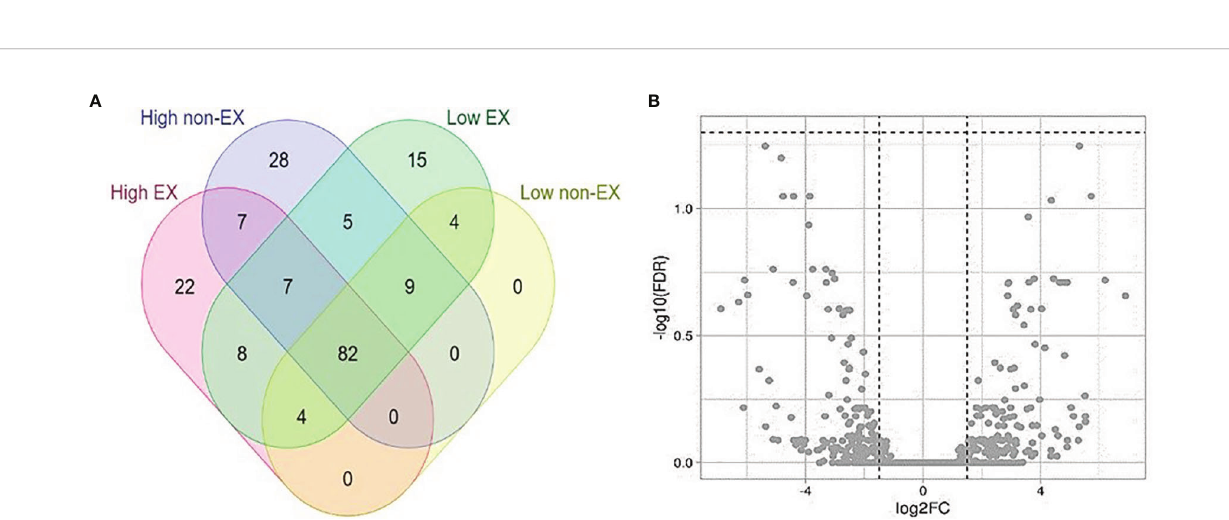
FIGURE 5 | (A) Novel miRNAs distributed among high and low tick resistant offspring plasma SEC samples (EX and non-EX). (B) Volcano plot of differentially expressed miRNAs in high and low tick resistant offspring SEC samples. The cut off values : [Y axis -log10(FDR) cut off is 1.3 (FDR < 0.05); X axis − 1.5 ≤ logFC ≥ 1.5].